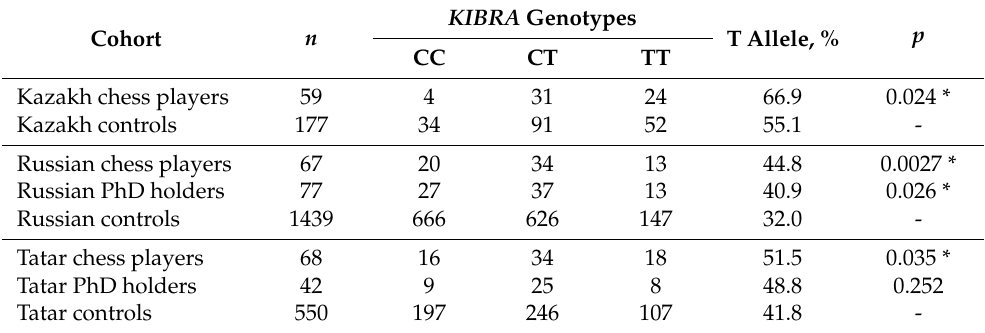
Table 2. KIBRA rs17070145 genotype distribution and T allele frequency in different cohorts.